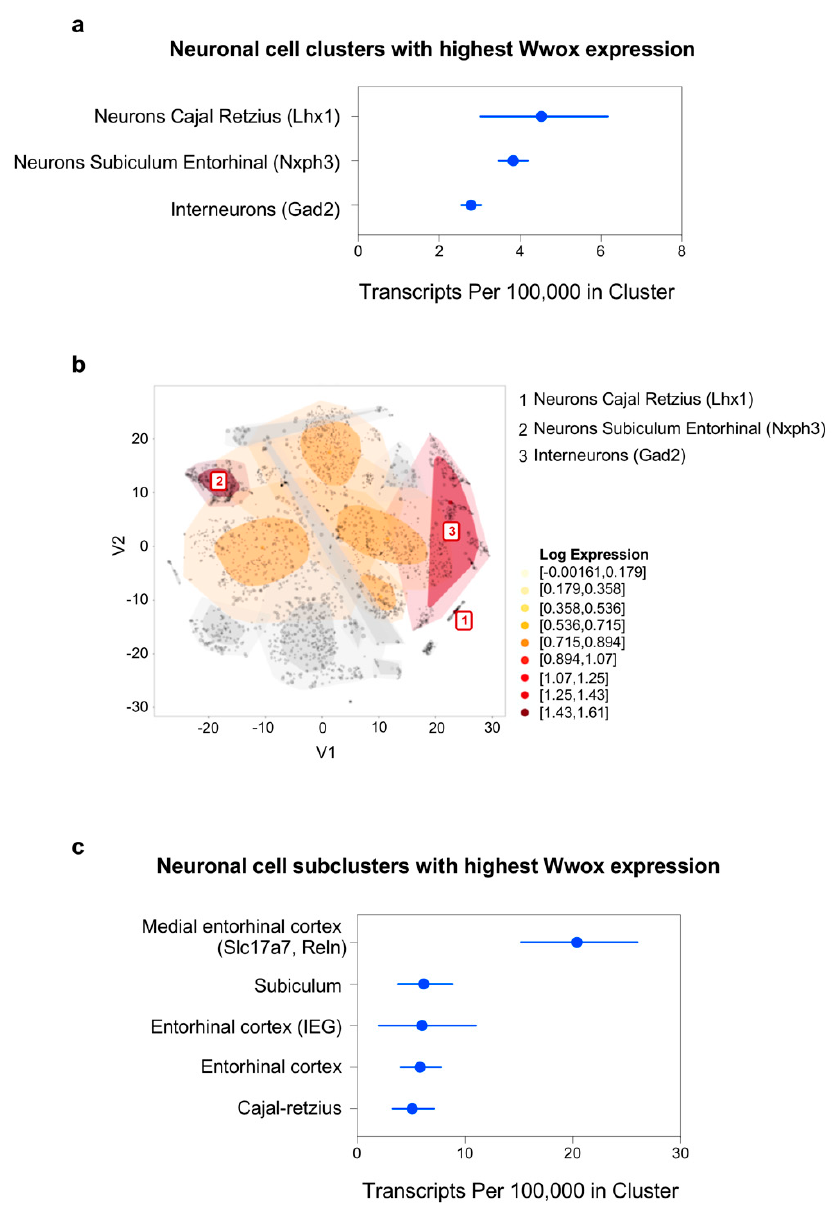
Figure 6. Wwox expression at single-cell level in mouse hippocampal neurons. ( a ) Graph representing the top three neuronal cell clusters expressing the highest number of Wwox transcripts identified by markers Lhx1, Nxph3 and Gad2 in mouse hippocampus. ( b ) These three clusters are shown in the t-SNE plot as the darkest colored regions. ( c ) Graph representing the hippocampal subclusters shows that neurons from the medial entorhinal cortex (markers Slc17a7 and Reln) express the most Wwox transcripts. The confidence intervals in graphs ( a , c ) reflect statistical sampling noise calculated from the binomial distribution and show the total number of UMIs ascertained by cluster. Data was obtained from the mouse brain scRNA-seq DropViz database (http://dropviz.org/) [28].